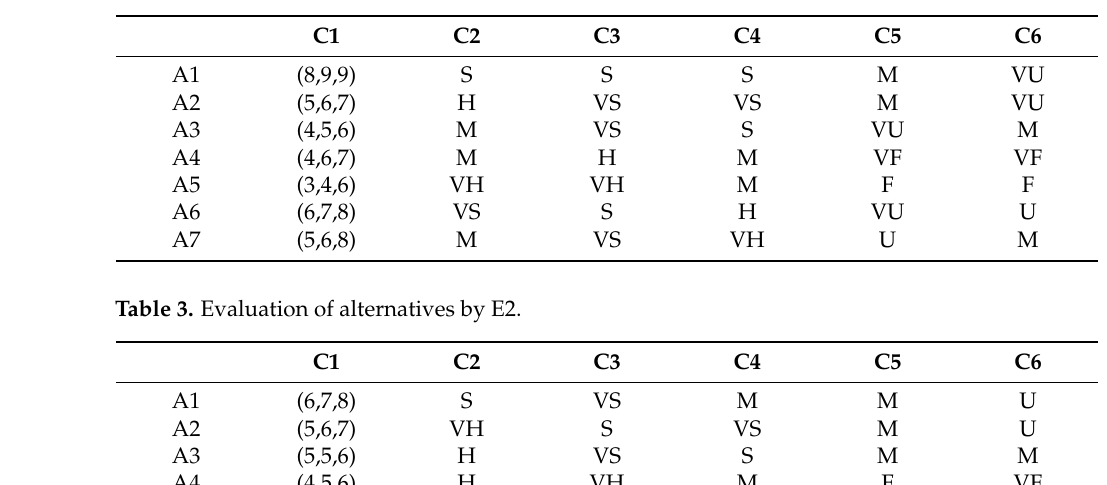
Table 2. Evaluation of alternatives by E1.